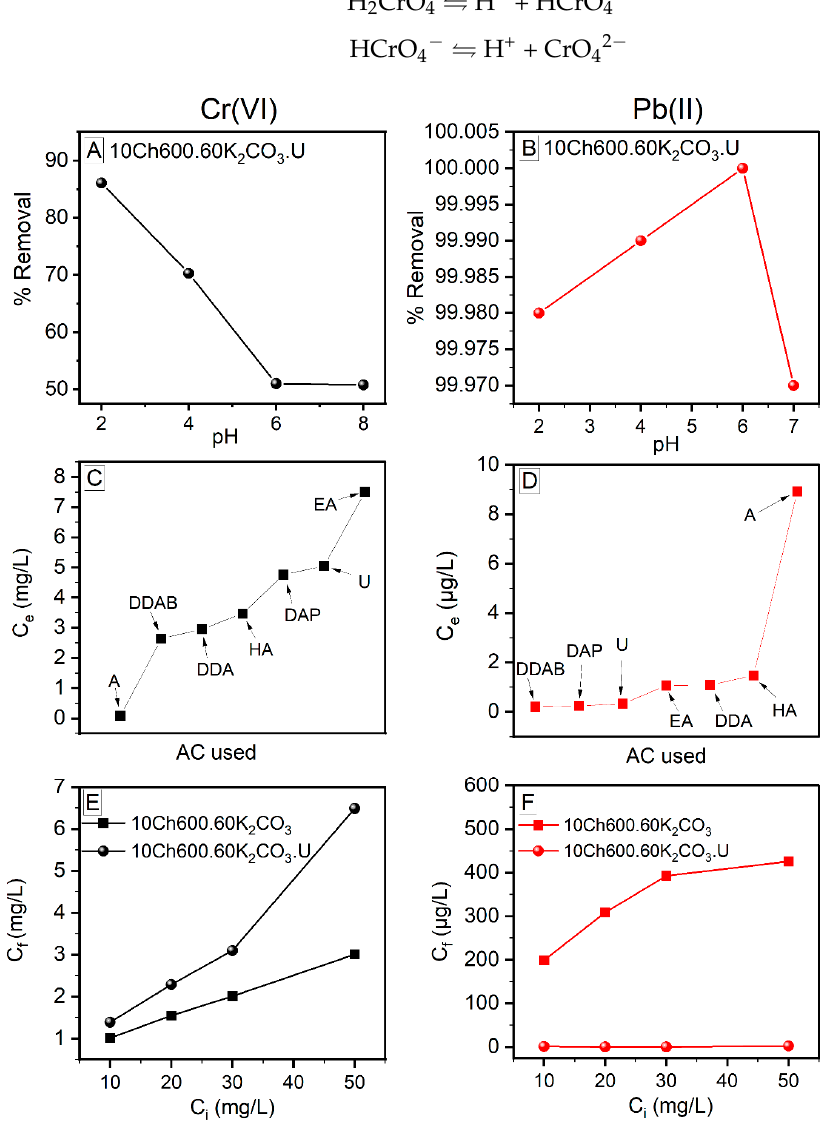
Figure 6. The behavior of Cr(VI) ( Left ) and Pb(II) ( Right ) ion removal with different parame- ters (explained in the List of Symbols and Units section). A, B: Effect of pH on the removal efficiency of heavy metals; C, D: Effect of different N enrichment reagents on the concentration of heavy metals at equilibrium; E, F: Comparison of the initial concentration of the heavy metals and their corresponding final concentration remained after the adsorption process. Conditions: AC dose: 10 g/L; the contact time: 1 h; T: 25 °C; Cr(VI) and Pb(II) C i: 10 mg/L (A − D); and Cr(VI) pH: 2, Pb(II) pH: 6 (C − F).